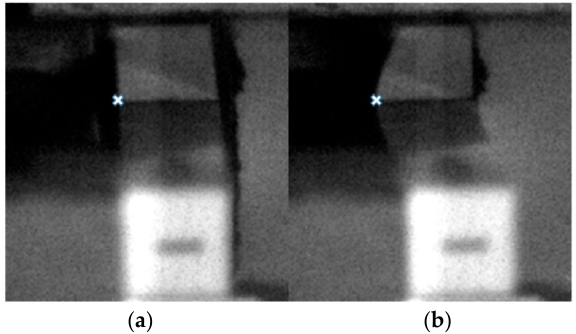
Figure 4. Maximum Deflection Measurement ( a ) just before impact and ( b ) just before fracture. The white “ ✖ ” denotes the tracked point before impact and at the initiation of fracture.